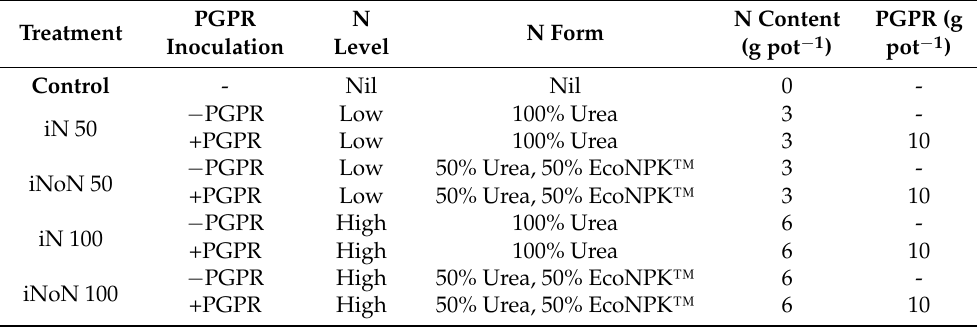
Table 1. Treatment compositions used for the macadamia seedling experiment. Each experimental treatment was applied to 20 replicate